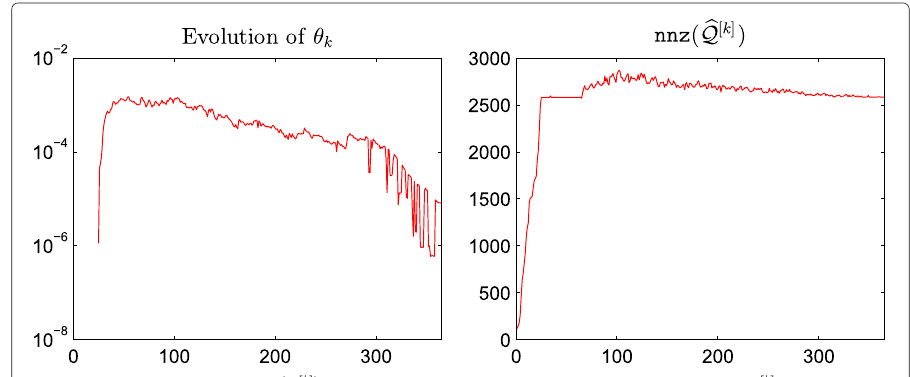
Fig. 7 Evolution of θ k and nnz to K , using α = 0.06